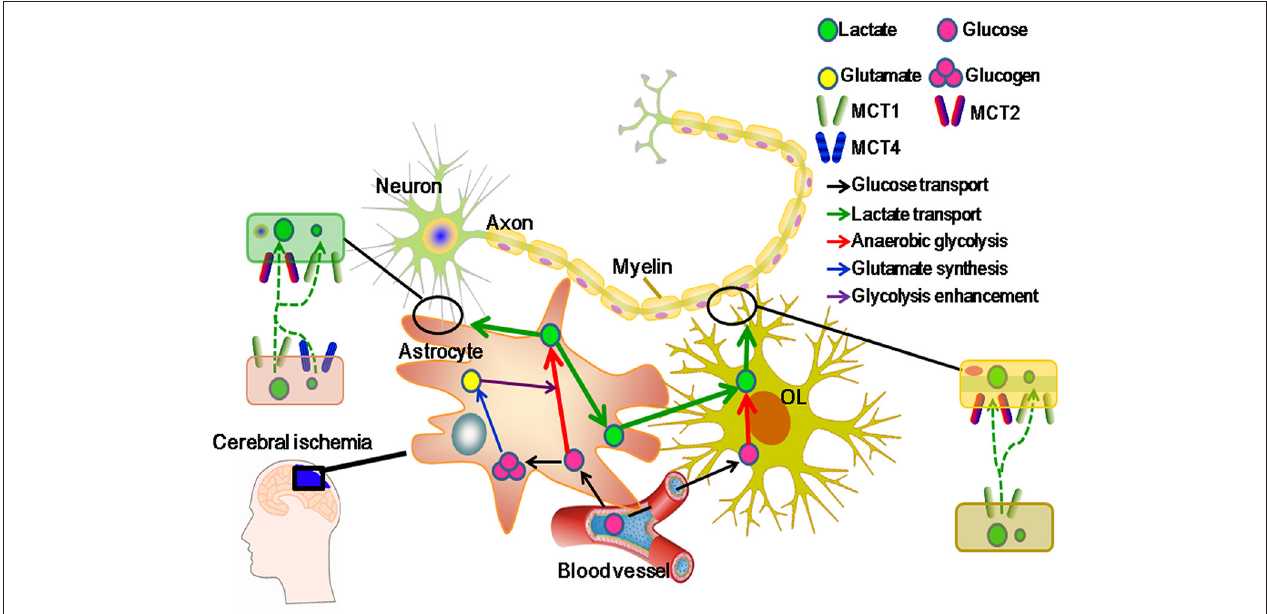
FIGURE 2 | Monocarboxylate transporter 1 (MCT1) regulatively facilitates lactate transport from glial cells to neurons in cerebral ischemia. MCT1 is expressed in glial cells, such as astrocytes and oligodendrocytes (OLs), and some populations of neurons in the areas of hippocampus, brainstem, trigeminal ganglion, and cerebellar Purkinje. Meanwhile, another three lactate transporters (MCT2, MCT3, and MCT4) are restricted to cell types: MCT2 in neurons, MCT3 in epithelial cells, and MCT4 in astrocytes. Moreover, MCT1 can regulate lactate influx and efflux among neural cells. MCT2 can merely regulate lactate influx and MCT4 mainly functions in